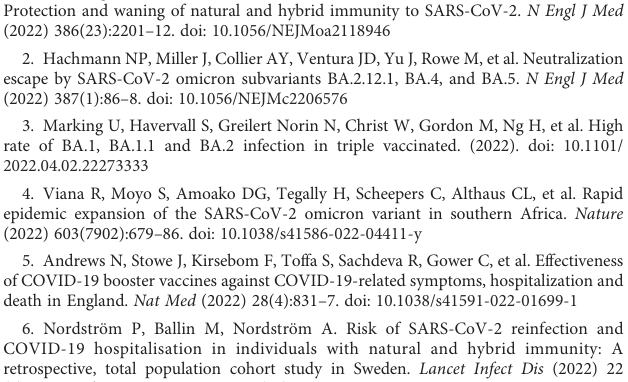
SUPPLEMENTARY TABLE 1 AIC comparison of exponential Vs. power law